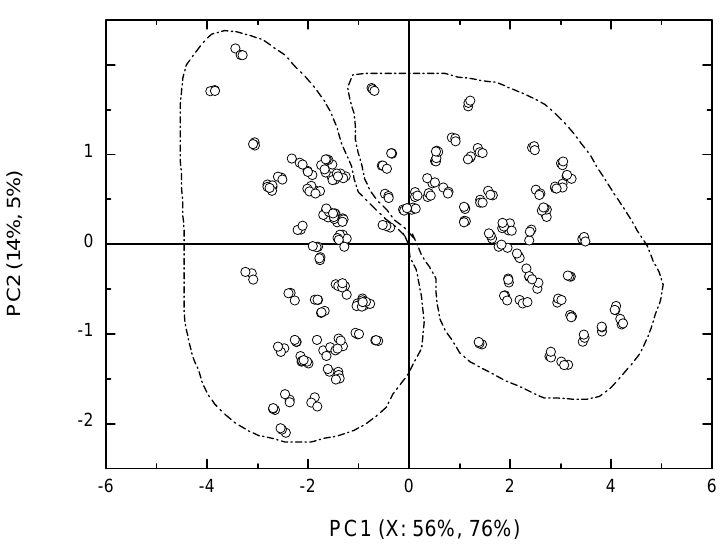
Figure 3 . PLS-1 score plot of all samples in test mixtures of key odorants containing ammonium (to right) and test mixtures of key odorants containing p-cresolate (to left) at pH 8. Full cross validation, PLS-DA was used and eight electrodes were sufficient.